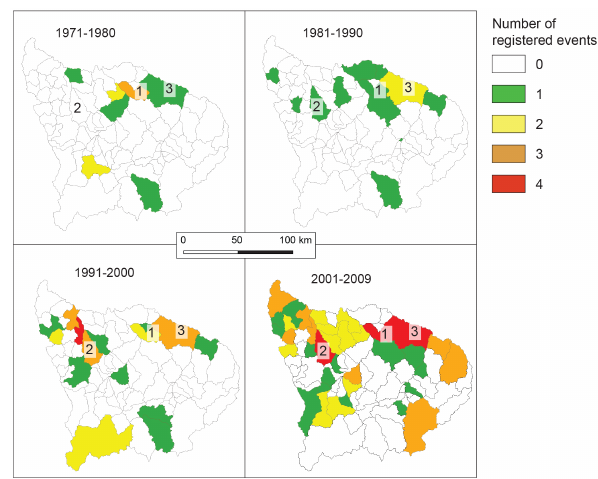
Figure 4. Spatiotemporal trends of disaster occurrence in the re- gion of Apurímac at the level of distritos over the time period 1971 to 2009. The inset numbers indicate the most affected distritos: (1) Abancay, (2) Andahuaylas, (3) Carhuasi.